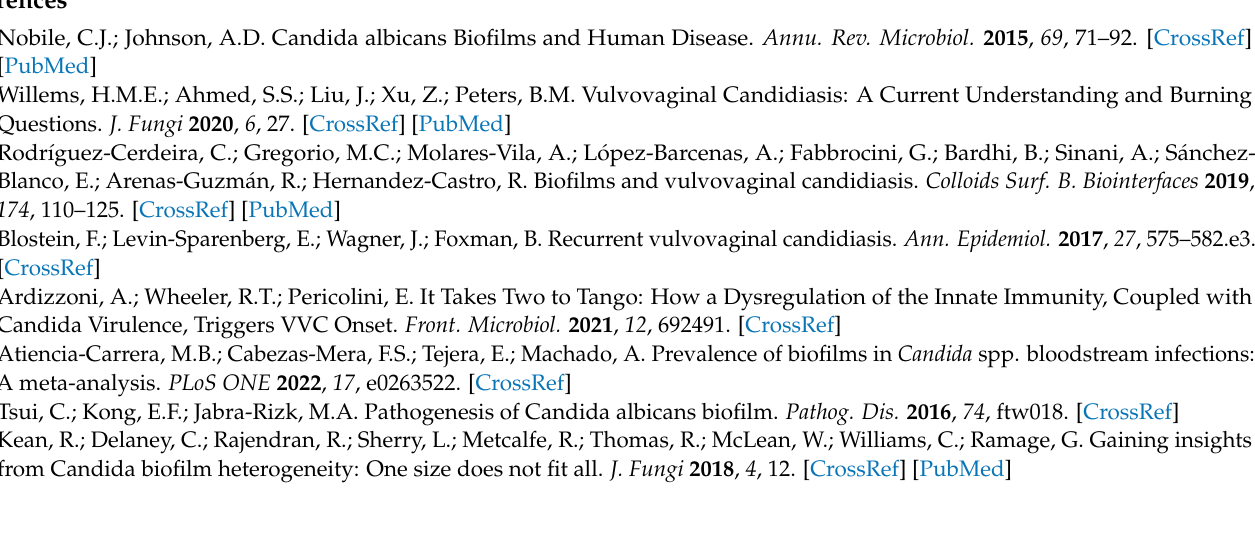
optimization; Figure S2: Evaluation of Candida cell morphology switching; Figure S3: Confocal microscopy analysis of Candida